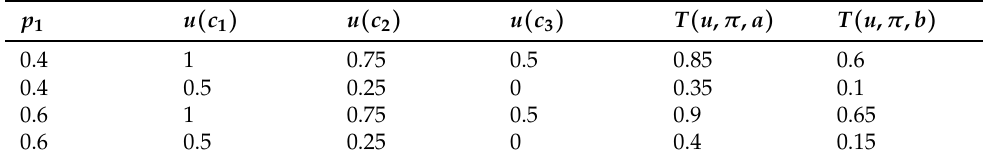
Table 2. Expected utilities of signing